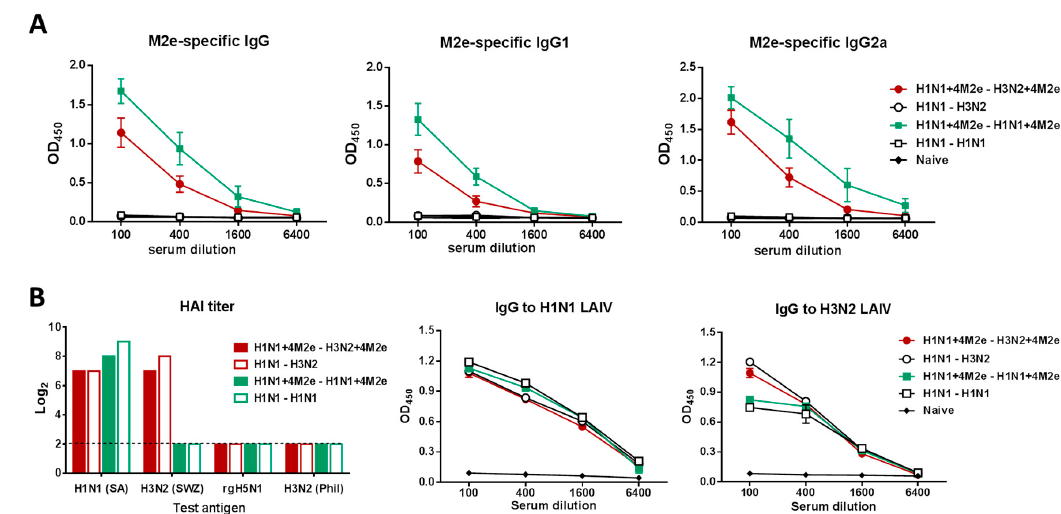
Figure 5. M2e-specific and influenza-specific antibody immune response after prime-boost vaccination. ( A ) M2e-specific serum IgG (left graph), IgG1 (middle graph) and IgG2a (right graph) antibodies were measured in ELISA using hM2e protein as a coating antigen. ( B ) Influenza virus-specific antibody responses. HAI antibodies were measured against a panel of influenza viruses using mouse sera after prime and boost vaccinations (left graph). The dotted line indicates the limit of antibody detection. Influenza-specific serum IgG antibodies were measured in ELISA against whole virus antigens H1N1 LAIV (middle graph) and H3N2 LAIV (right graph).